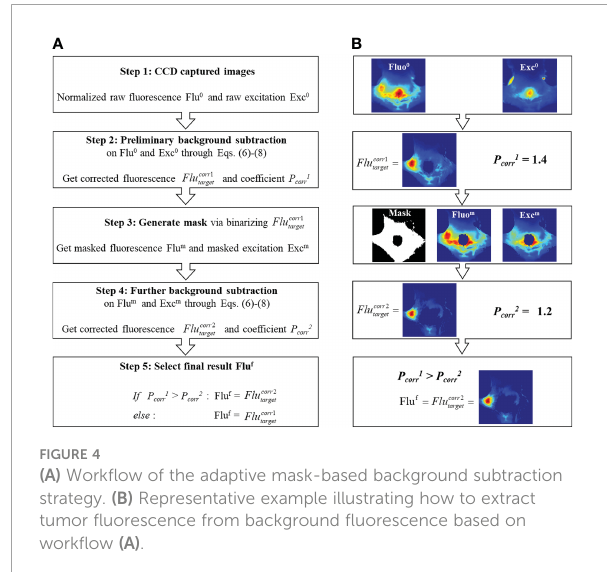
FIGURE 4 (A) Work fl ow of the adaptive mask-based background subtraction strategy. (B) Representative example illustrating how to extract tumor fl uorescence from background fl uorescence based on work fl ow (A)